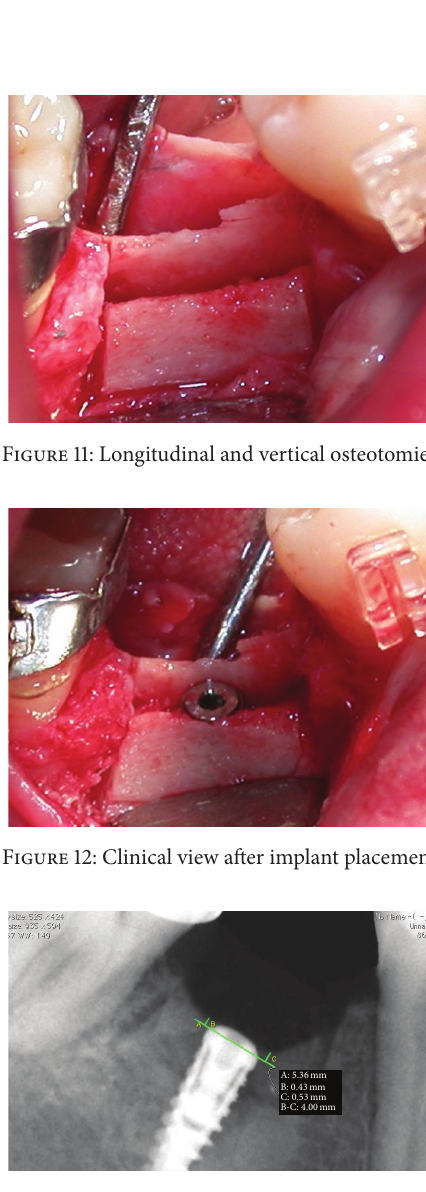
Figure 13: Immediate postoperative radiograph.